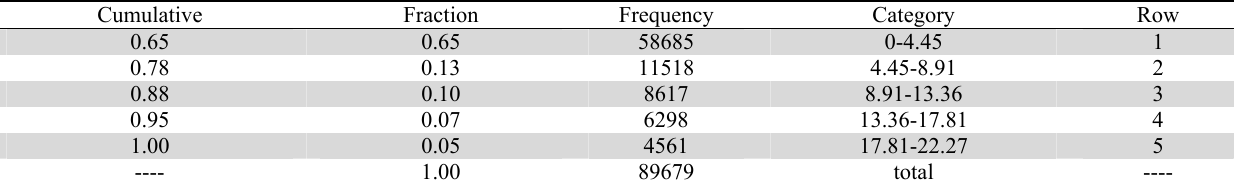
ATMs Daily Cash Withdraw Distribution